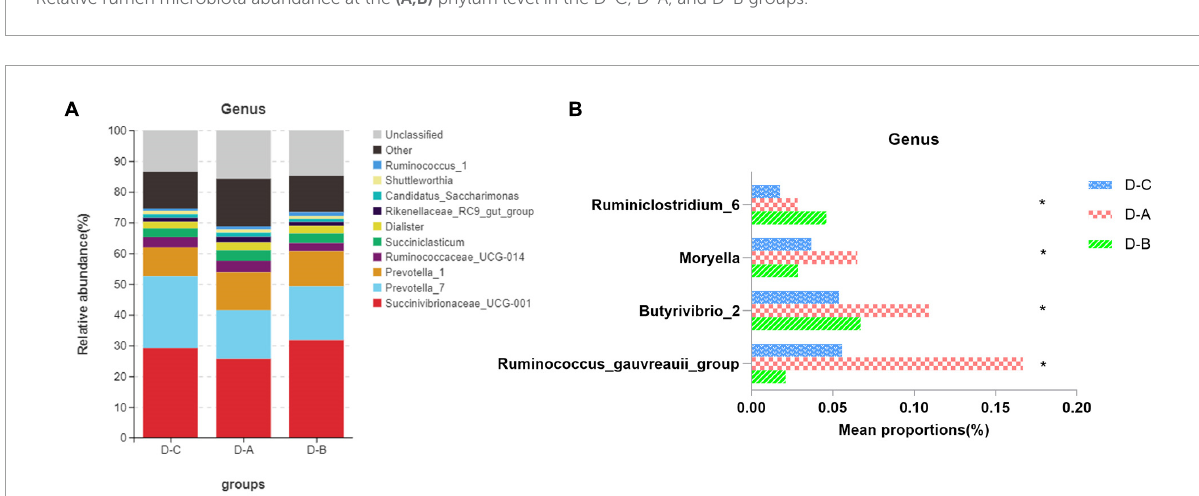
FIGURE4 Relative rumen microbiota abundance at the (A,B) genus level in the D-C, D-A, and D-B groups. * P <